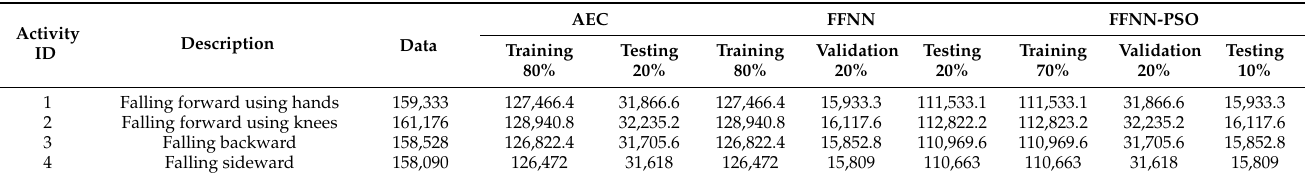
Table 1. The distribution of activity data.